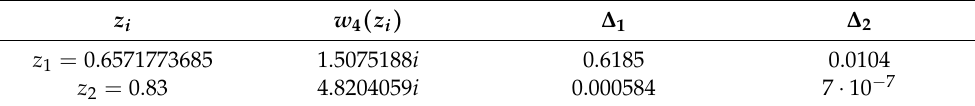
Table 1. Characteristics of the